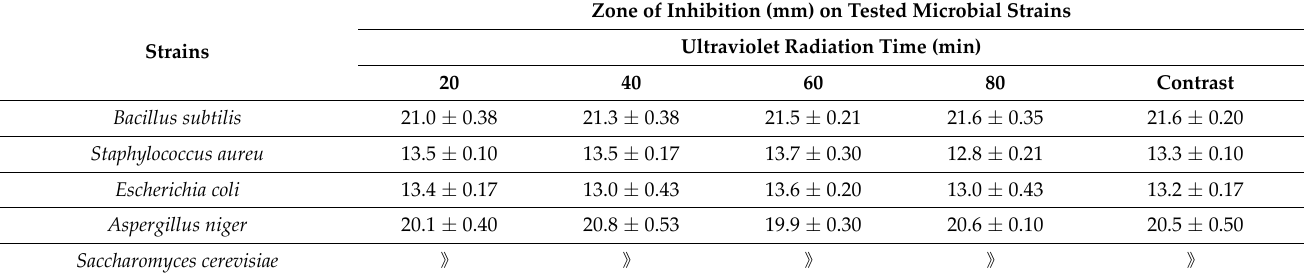
Table 5. Antimicrobial activities of Allium tenuissimum L. flowers essential oil after ultraviolet radia‑ tion against the tested microorganisms.